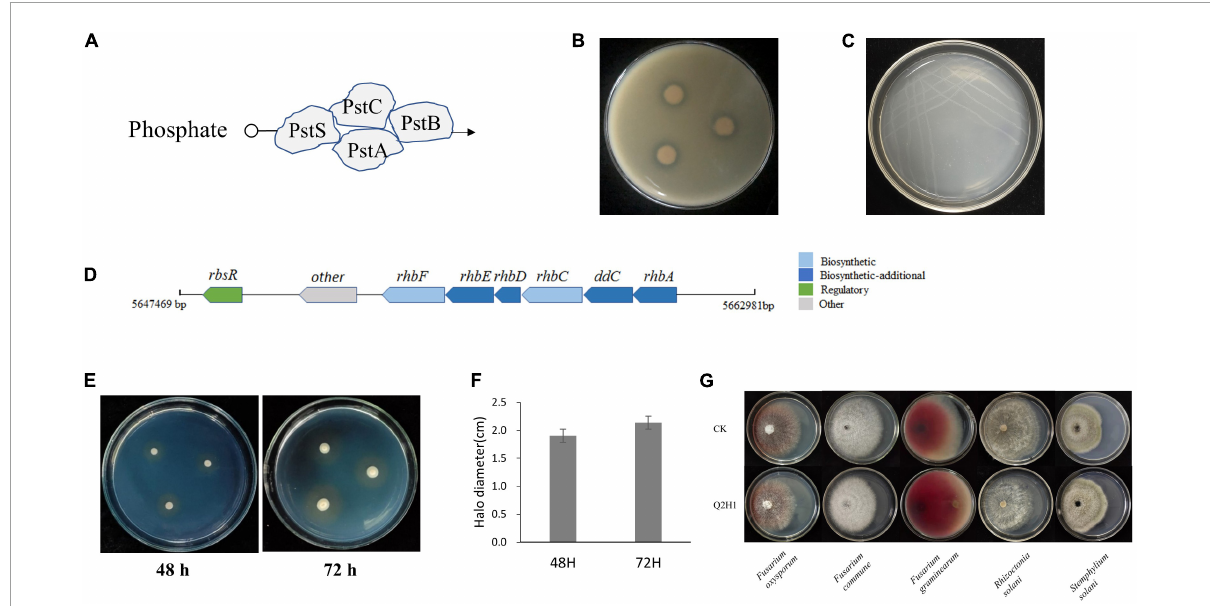
FIGURE4 In vitro assay of PGP activity: (A) Phosphate transport pattern diagram. (B) Phosphate solubilization experiment in organic phosphate medium. (C) Ashby nitrogen-free medium. (D) Siderophore gene cluster arrangement. (E) Siderophore CAS detection medium. (F) Diameter of the halo in CAS medium at 48 h and 72 h. (G) Antagonism of Q2H1 against pathogenic